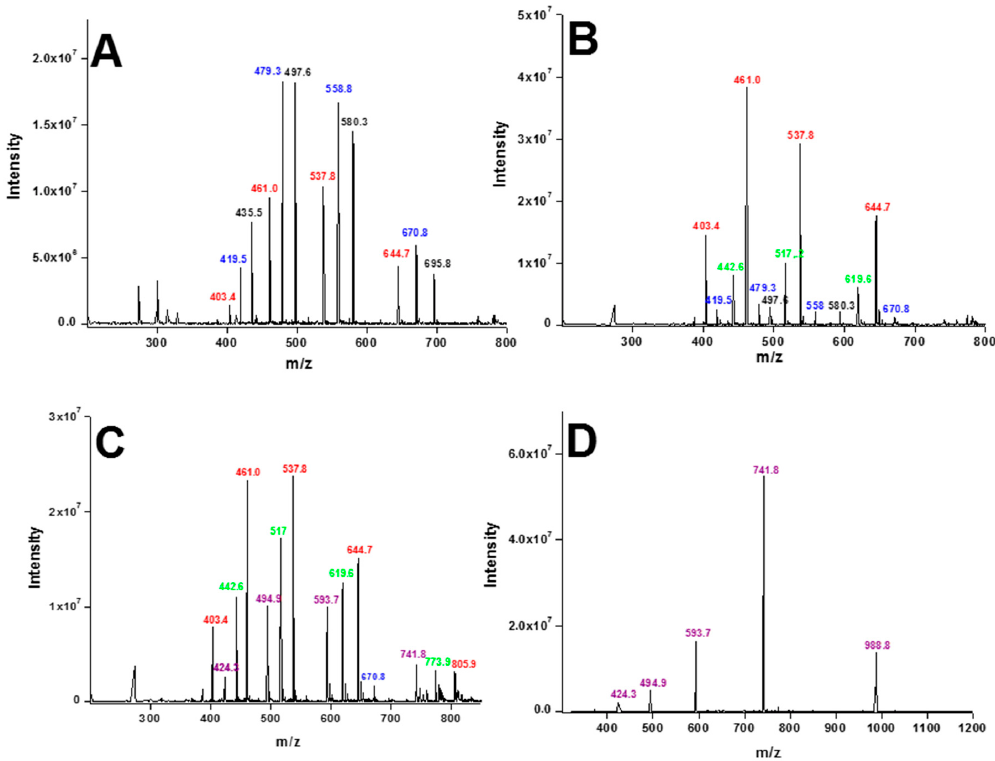
Figure 2. Serum stability analyses by mass spectrometry. Analyses of peptides and degradation products were performed after ( A ) 5 min, ( B ) 20 min, ( C ) 30 min, and ( D ) 120 min of incubation in human serum. Molecular ions: intact (p-BthTX-I) 2 , black; (p-BthTX-I) 2 minus one Lys residue, blue; (p-BthTX-I) 2 minus two Lys residues, red; (p-BthTX-I) 2 minus three Lys residues, green; and (p-BthTX-I) 2 without four Lys residues,